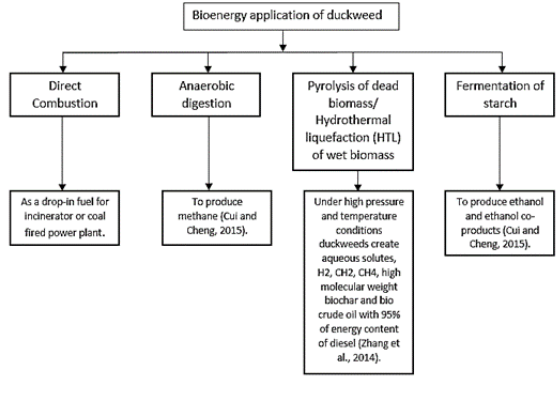
Figure 2. Bioenergy applications